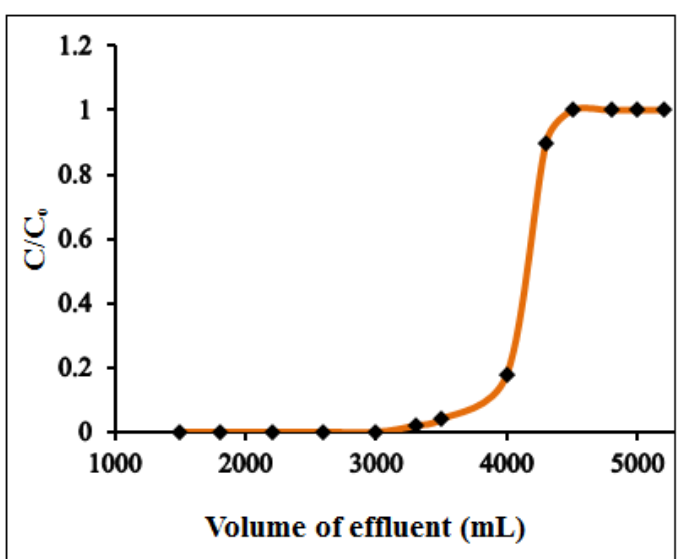
Figure 8. Breakthrough curve for the adsorption of Hg(II) (experimental conditions: sorbent amount 0.5 g; pH = 6.0; flow rate = 8 mL min − 1 , Hg 2 + 10 mg L − 1 Table 1. Analytical data of preconcentration and breakthrough studies (column parameters: sample